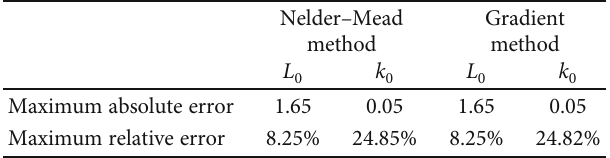
Table 4: Results of calculations with an error α = 15 % .